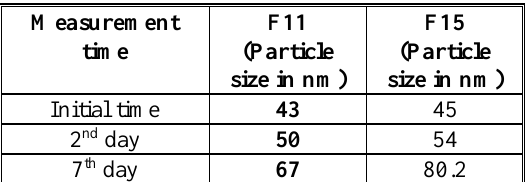
Table 6. Physical stability study for F11 and